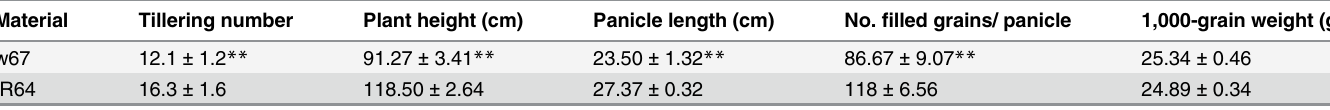
Table 1. The main agronomic traits of w67 and wild type IR64.